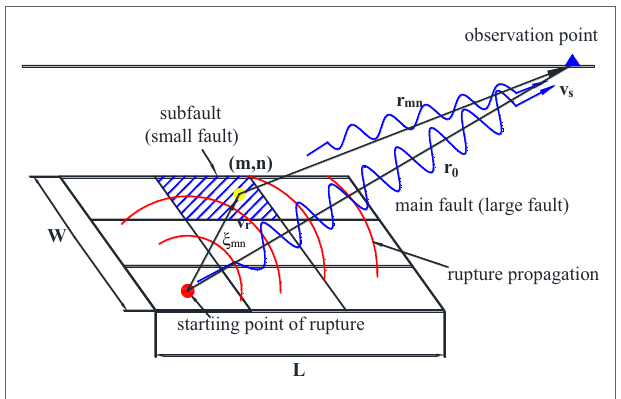
FigUre 6 | schematic illustrations of stochastic green’s function method .